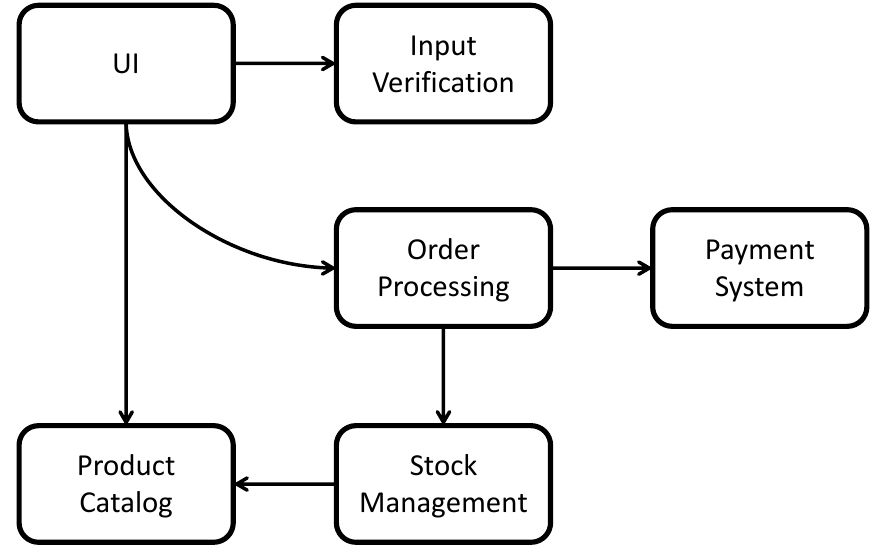
Figure 18. Components of Web Shop Applications and their